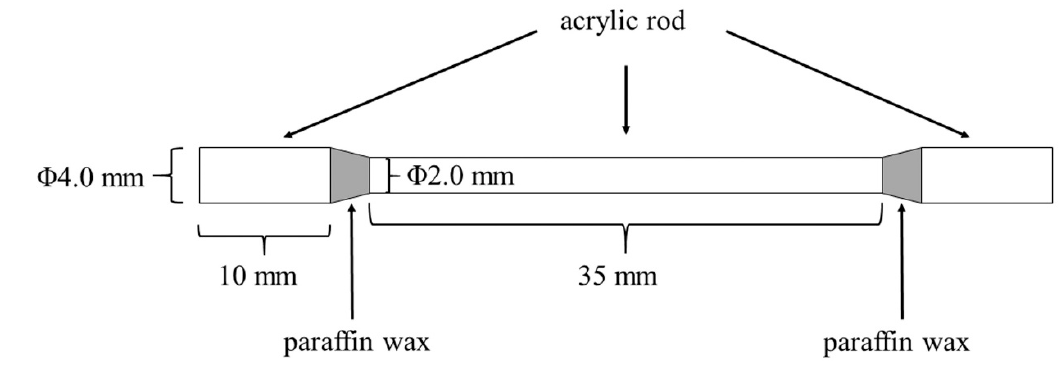
Figure 2. The pattern of the cast specimen. Table 1. Metals used in this study.